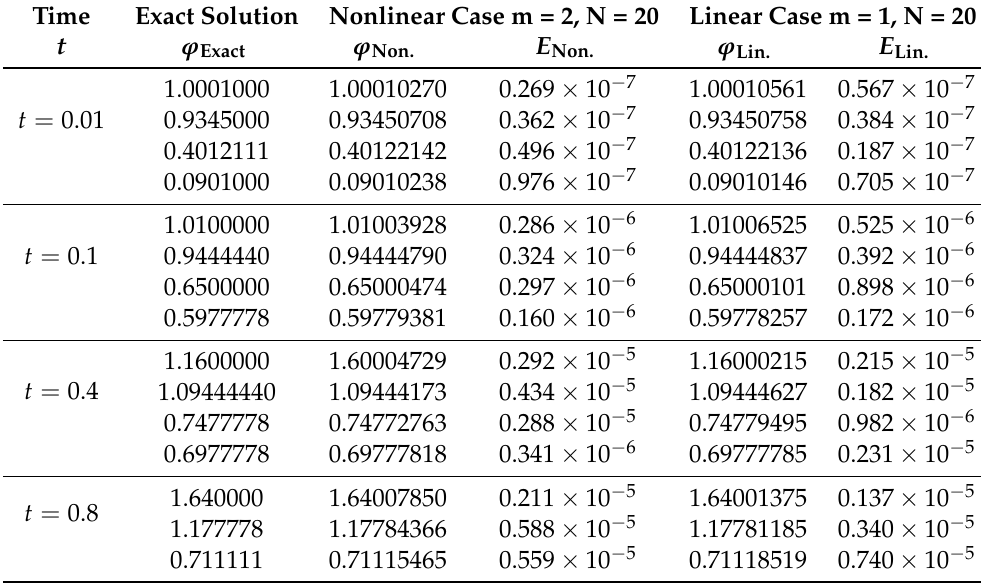
Figure 5. ( a , b ) Shows the error of Equation (44) with Hilbert kernel for the nonlinear and the linear cases at time t = 0.4, N = 20. Table 1. Solutions of the linear/nonlinear solutions of MIE (44) with a logarithmic kernel, along with the corresponding errors using